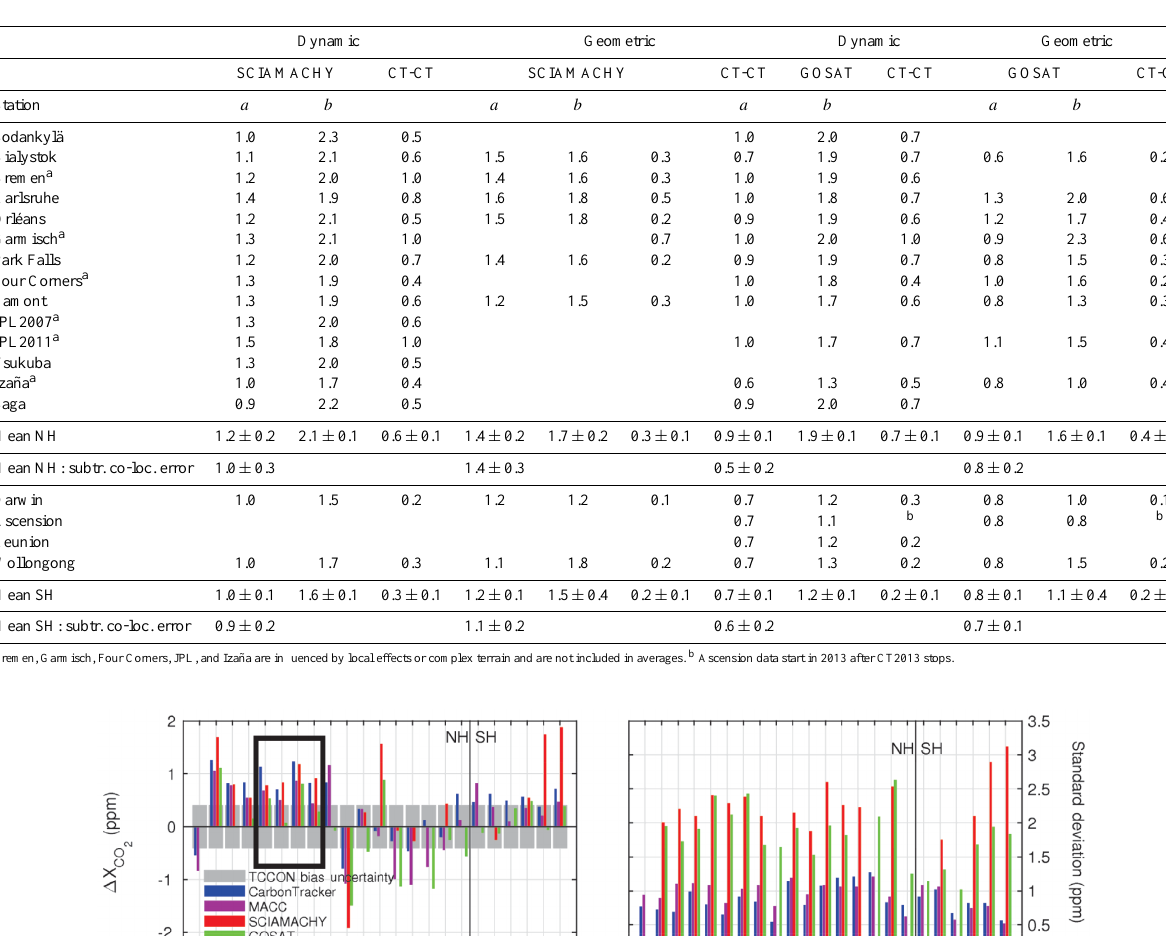
Table 2. Fit of a and b in Eq. (2), with stations having data out to at least n = 50 for dynamic coincidence criteria, n = 10 (GOSAT) or n = 40 (SCIAMACHY) for geometric coincidence criteria. The CT-CT column describes the CT2013b coincidence error, providing a lower bound on the satellite/TCCON differences. The subtr. co-location error row estimates the correlated error for satellites only, subtracting the quadrature TCCON error (0.35ppm) and co-location error from the CT-CT column.